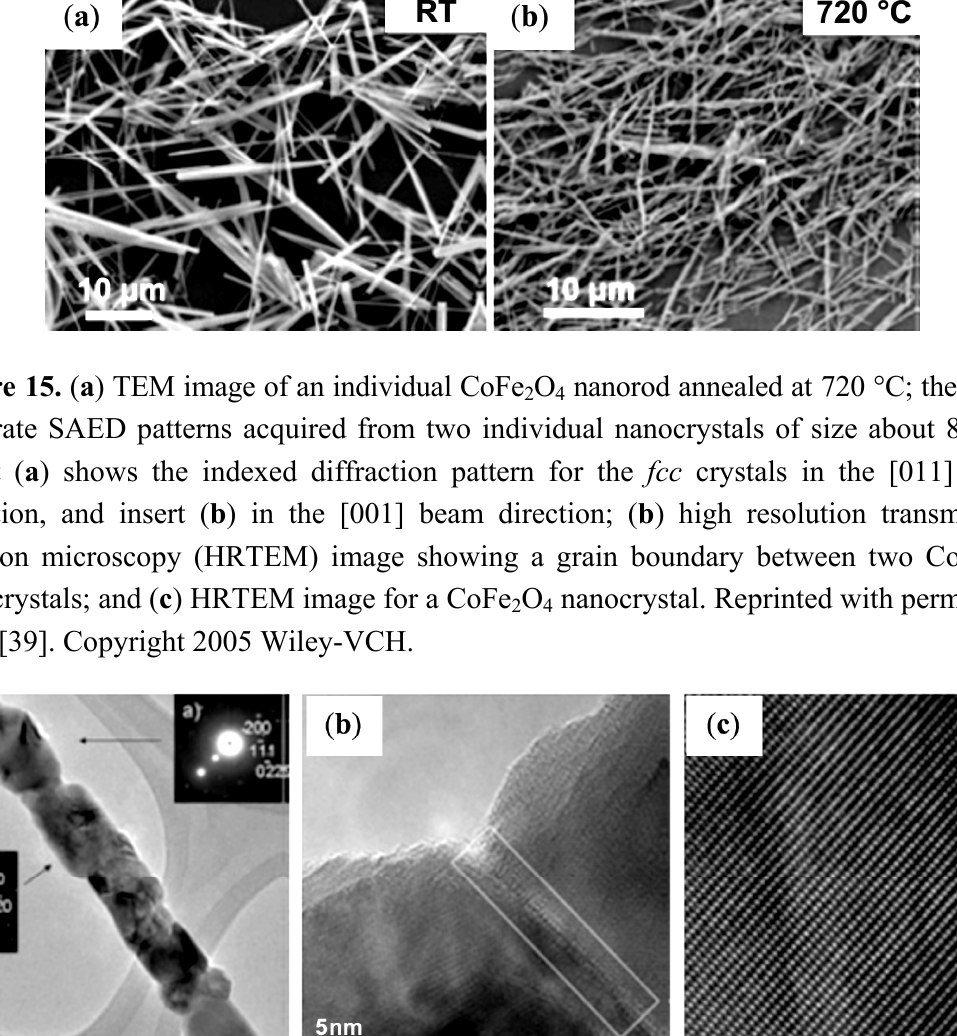
(C O ) 2 2 4 3 O rods annealed at 720 °C. 2 4